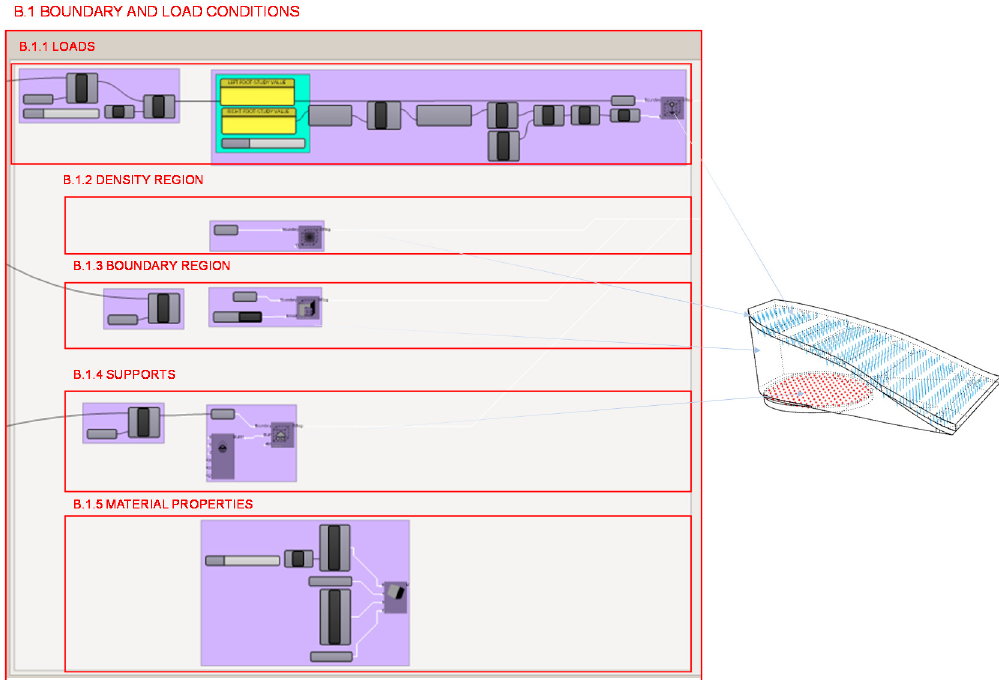
Figure 19. Programming structure definition developed for the boundary and load conditions for the topology optimization of the heel.